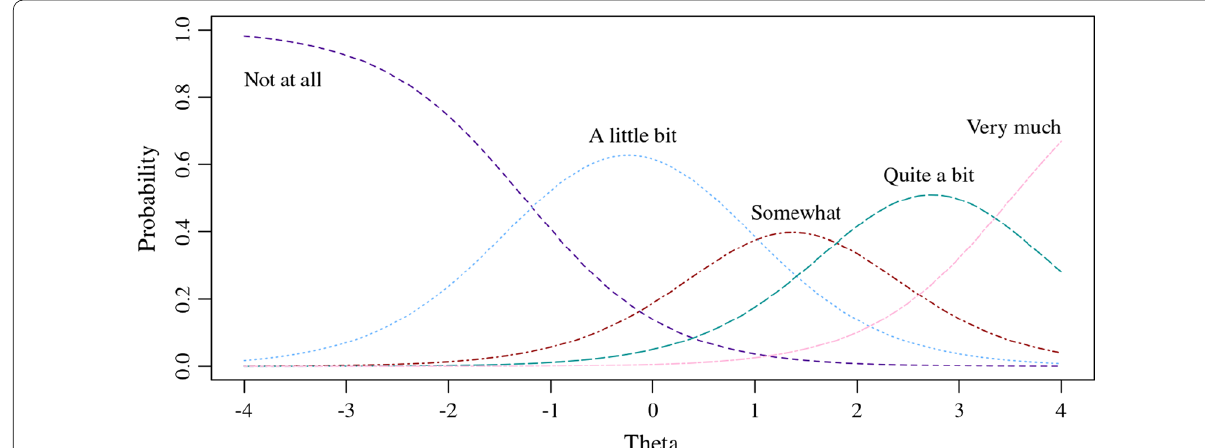
Fig. 1 Response option probabilities across theta for PROMIS Fatigue item FATEXP42